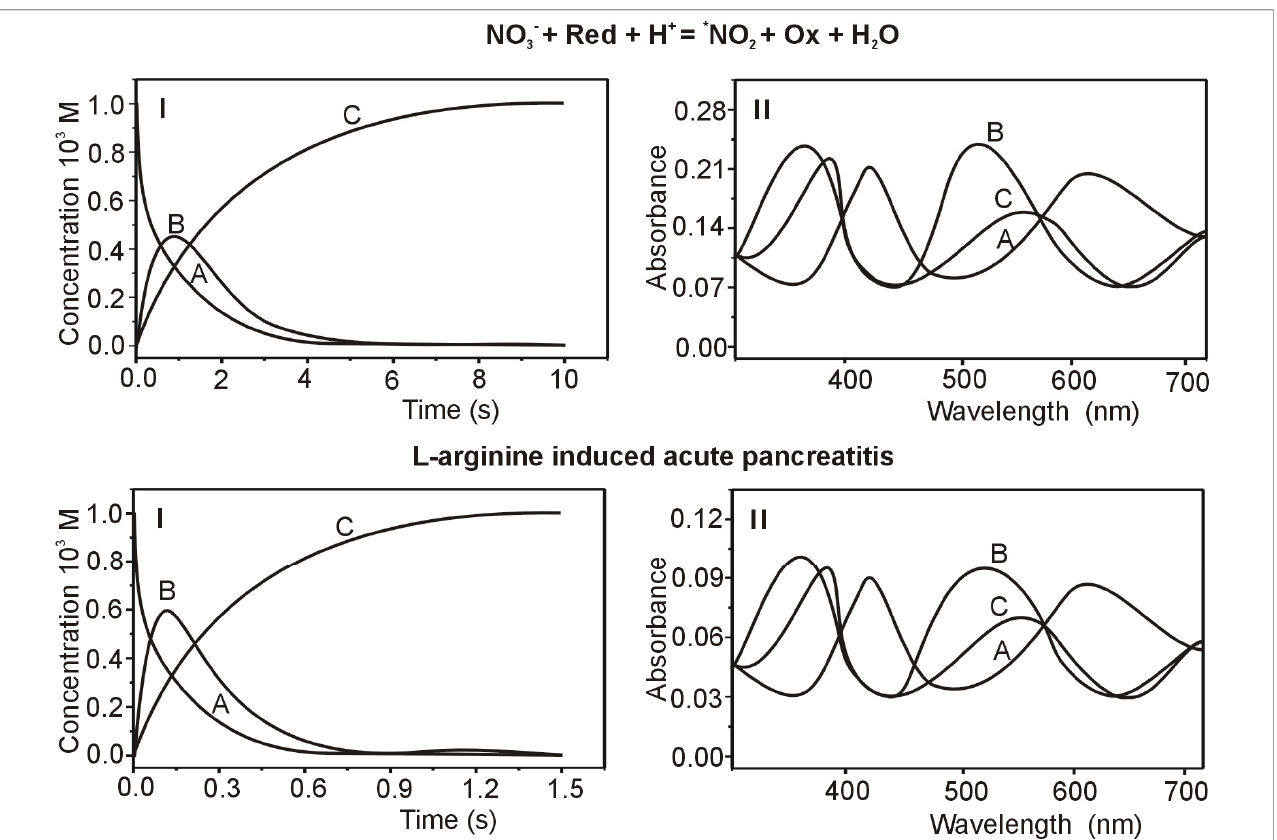
Figure 1. (I) Comparison of kinetic and spectral characteristics of reactants in simple inorganic • NO generating system and pancreatic cytosol fraction. (II) Absorption spectra 2 of the reactants A, B and C at pH = 7.12, [NO ] = 2.48E-5, T = 20 2